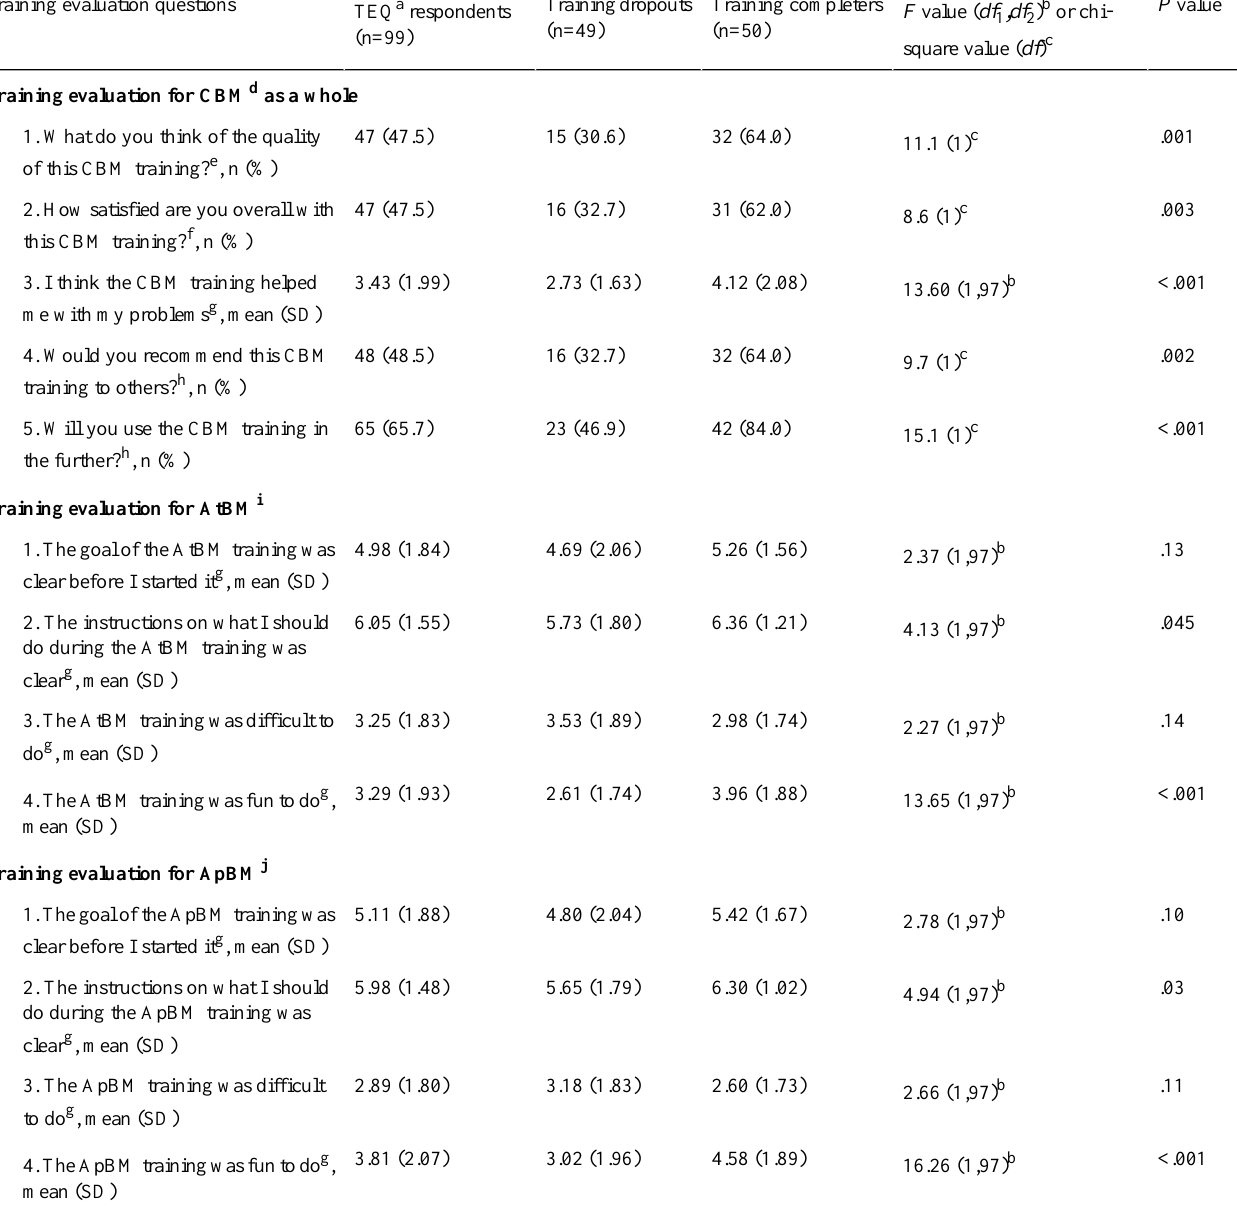
P value F value ( df